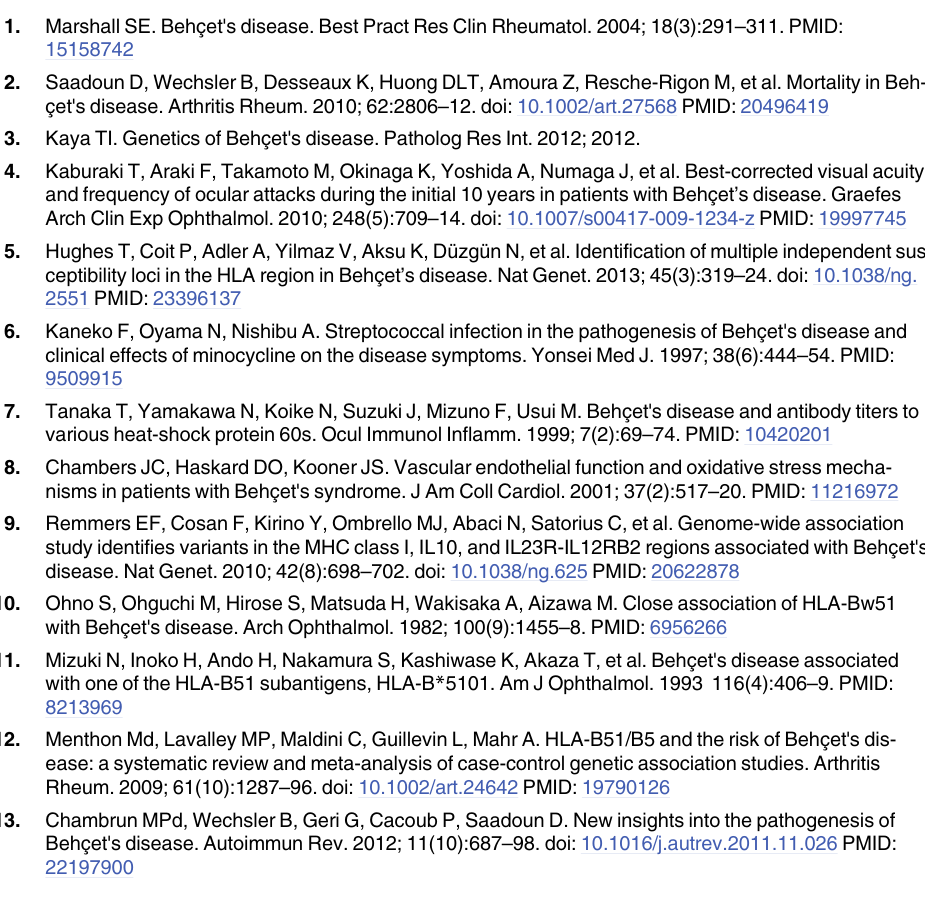
S1 Table. Crystal structures used for simulation and number of reported BD patients in association and non-association with HLAs. S2 Table. HLA residues with a total decomposition (DC) free energy ( Δ G -0.5